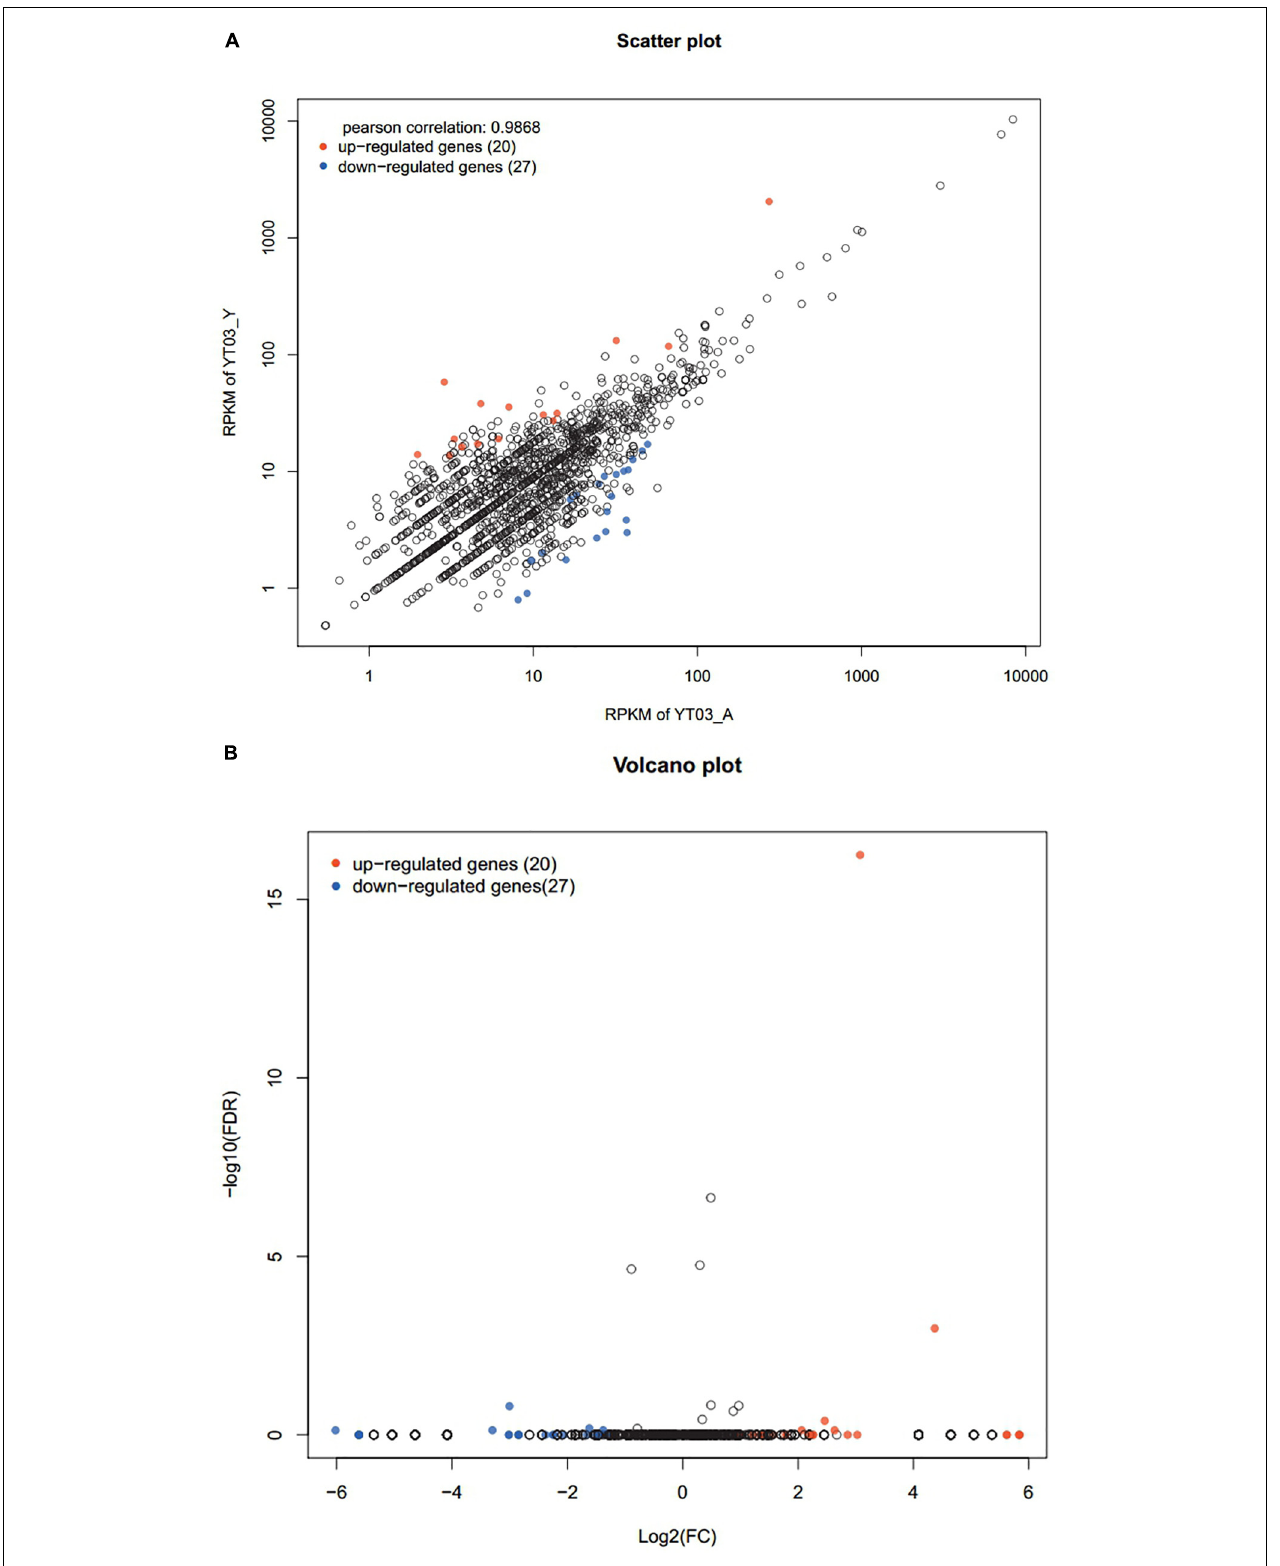
FIGURE 6 | Scatter plot (A) and volcanic plot (B) of differentially expressed genes (red dots indicate significantly up-regulated genes, blue dots indicate significantly down-regulated genes, and black dots are non-significantly different genes).